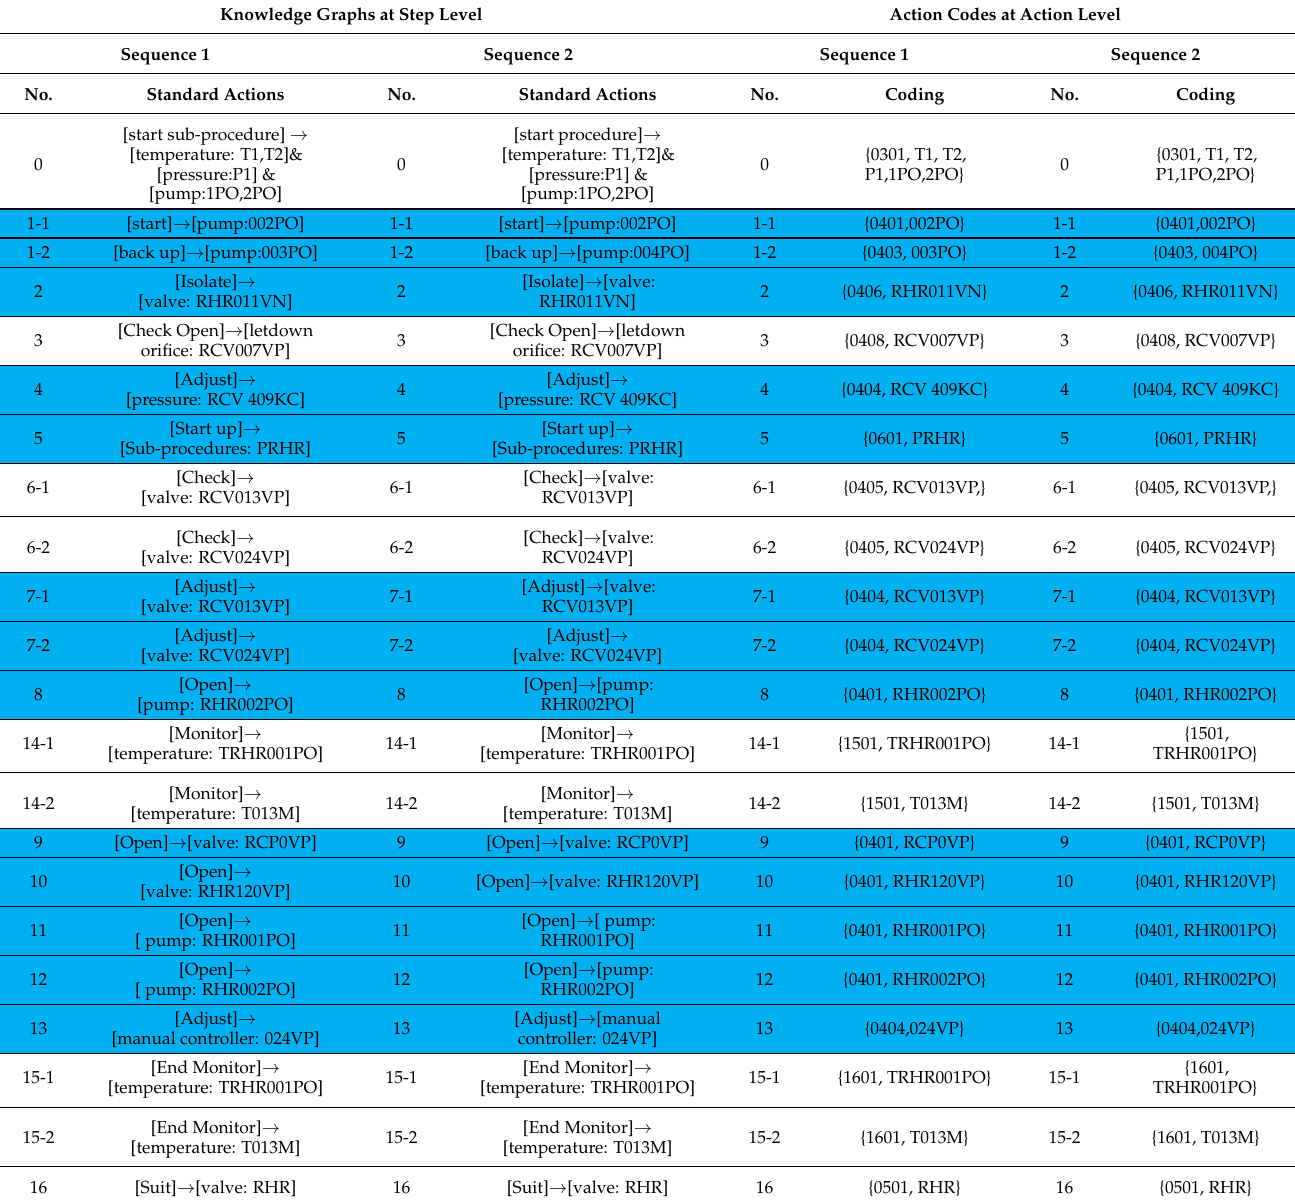
Table 5. The knowledge graph model and the action code of each step at step level and action